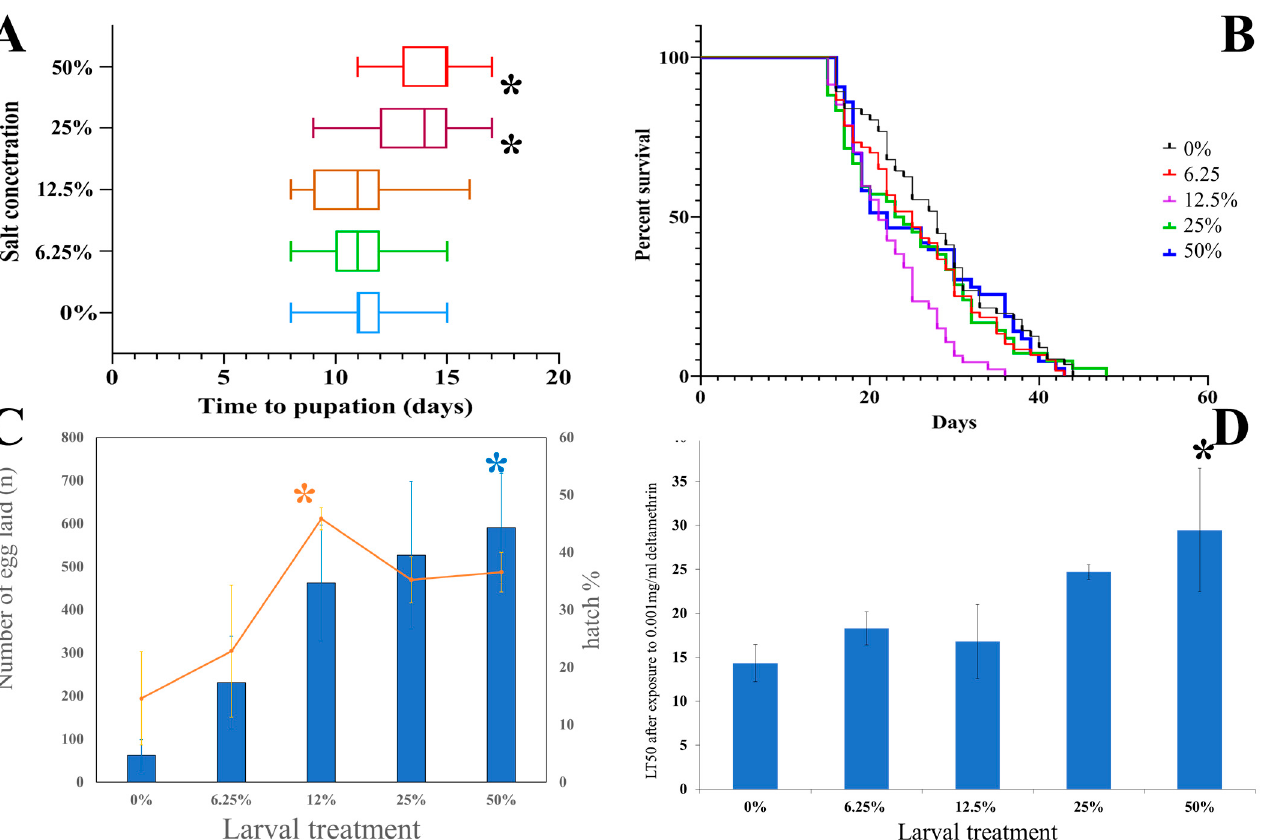
Figure 1. The effect of variable larval salt concentration on life history traits of Anopheles merus. ( A ) Time-to-pupation in different larval salt concentrations. Asterisks (*) indicate a significant difference from the untreated control. ( B ) Adult longevity of female An. merus after rearing in different larval salt exposures. ( C ) Fertility and fecundity of adults reared in different larval salt concentrations. Blue bars represent number of eggs, and the orange line represents hatch percentage. Blue asterisks represent a significantly different number of eggs from the control. Orange asterisks represent a significantly different hatch percentage from the untreated control. ( D ) Deltamethrin lethal time of adults reared in different larval salt concentrations. Asterisks indicate a significant difference from the untreated control.